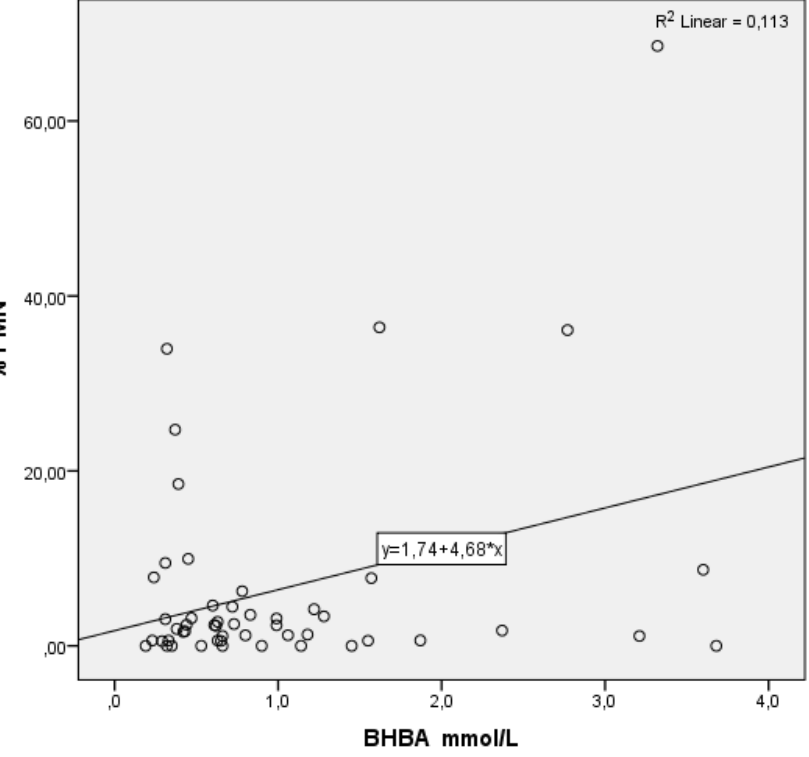
Figure 3. Partial regression graphic of β -hydroxybutyrate acid (BHBA, independent variable) and its relation with the percentage of polymorphonuclear neutrophils (%PMN, dependent variable). As is depicted in Figure 4, 60% of the animals with clinical ketosis also suffered from subclinical endometritis. This number decreased to 13.5% when healthy cows were con- sidered.